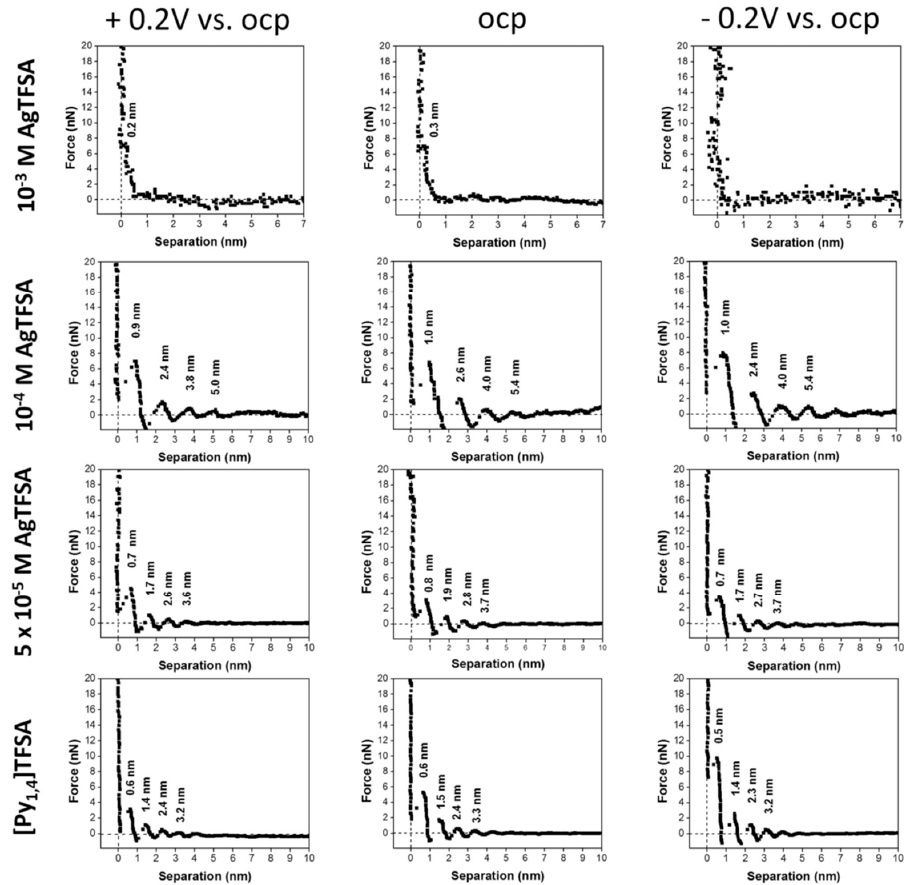
Figure 16. Force–separation curves measured in [Py 1,4 ][TFSA] with different concentrations of Ag on the Au surface. Adapted from Hoffmann et al.